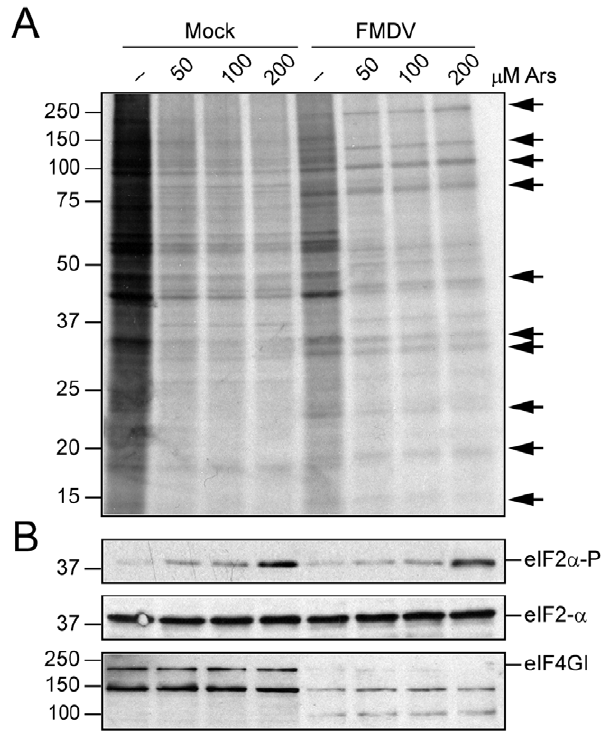
Figure 7. Action of Ars on FMDV infection. A) BHK cells were mock infected or infected with FMDV (10 pfu/cell). At 3 hpicultures were treated with different amounts of Ars (0, 50, 100 and 200 m M) for 15 min and next labeled by [ 35 S]Met-Cys labelling in presence of the same concentrations of Ars from 3.15–4 hpi. Samples were collected and analyzed by SDS-PAGE, fluorography and autoradiography. B) The phosphorylated form of eIF2 a and total eIF2 a were determined in parallel by Western blot with specific antibodies. The cleavage of eIF4GI was also analyzed by Western blot using specific antibodies against this factor. The arrows indicate viral